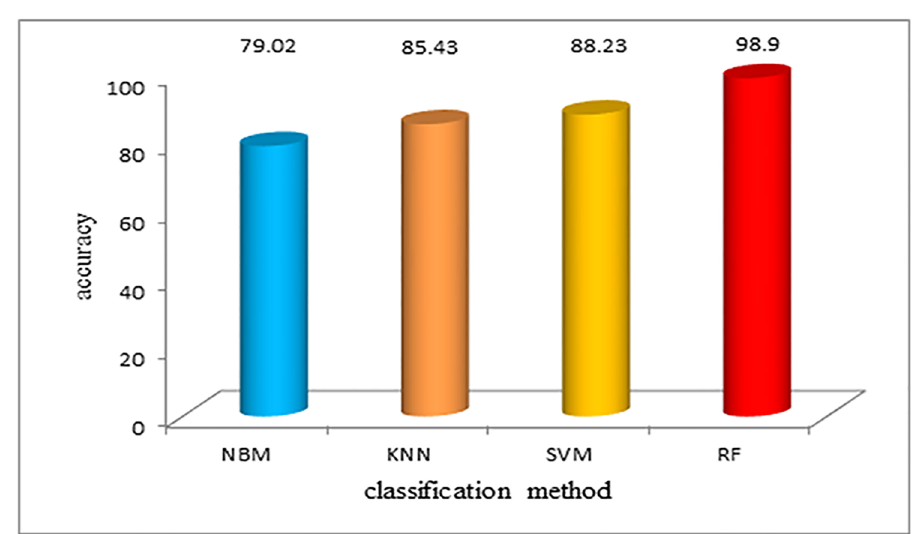
Fig 10. Classification accuracyusing different algorithms before dimension reduction. Before the dimensionreduction of the data, the classificationaccuracyof the four algorithmsis shown in Fig 10. Comparingthe accuracyof the algorithm, the RF algorithmhas the highest classification accuracy. Due to the limitationof the multi-classclassificationproblems, randomforest has better tolerance, excellent performance, and the highest classification accuracy before